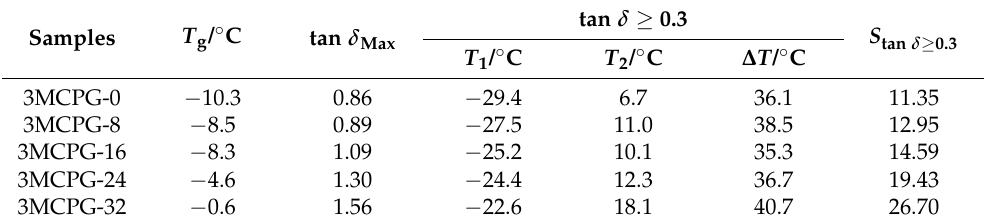
Table 3. Mechanical properties of the MPU/AO-80 composites, as evaluated by DMA.